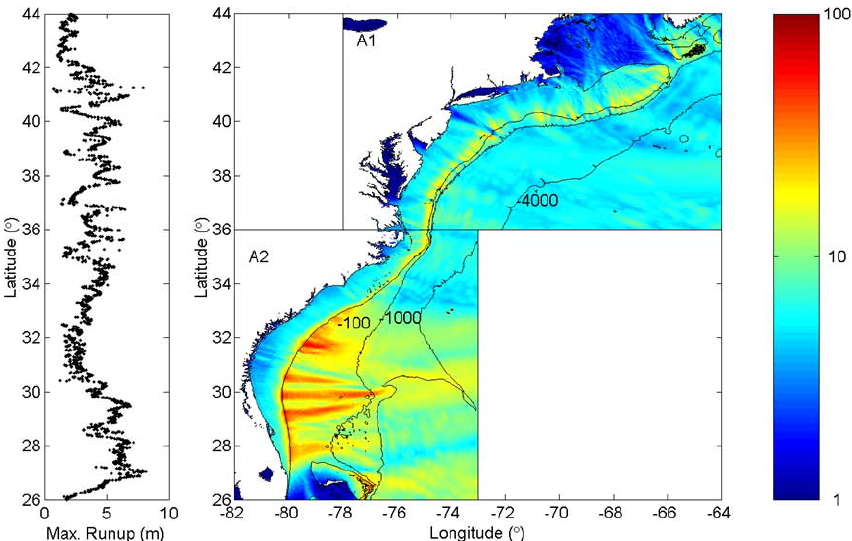
Fig. 23. Maximum water surface elevations (m) near the US and maximum runup on the coast. The solid lines in ocean indicate depths of 4000, 1000 and 100m.